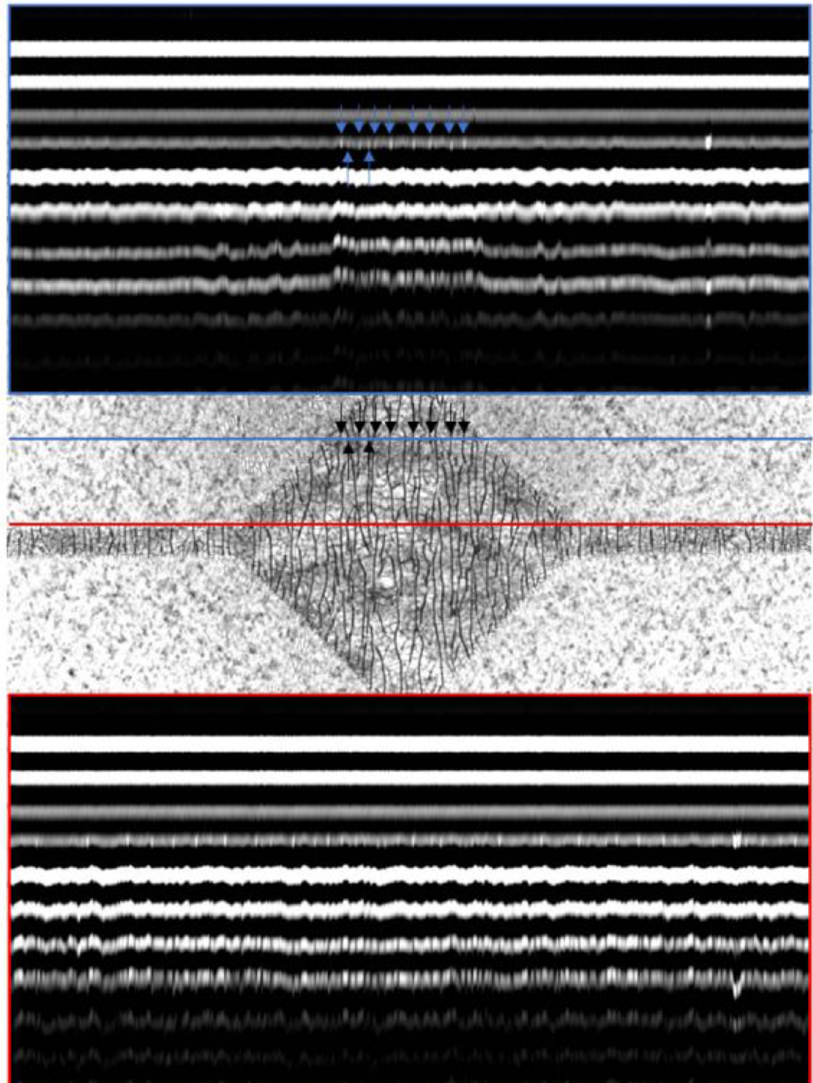
Fig. 7. Acoustic cross-sections of a module with F-C/PET/PP backsheet revealing internal cracks (top and bottom), taken at the lines indicated in the micrograph